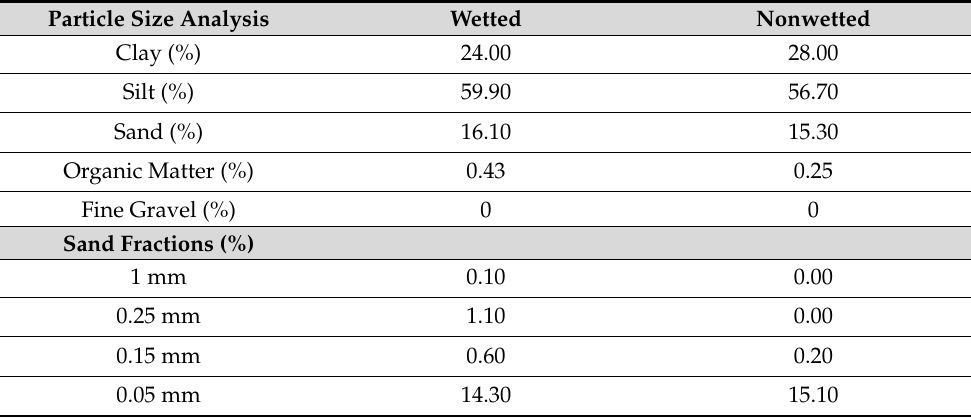
Table 1. Particle size distribution of wetted and nonwetted simulated fallout material.